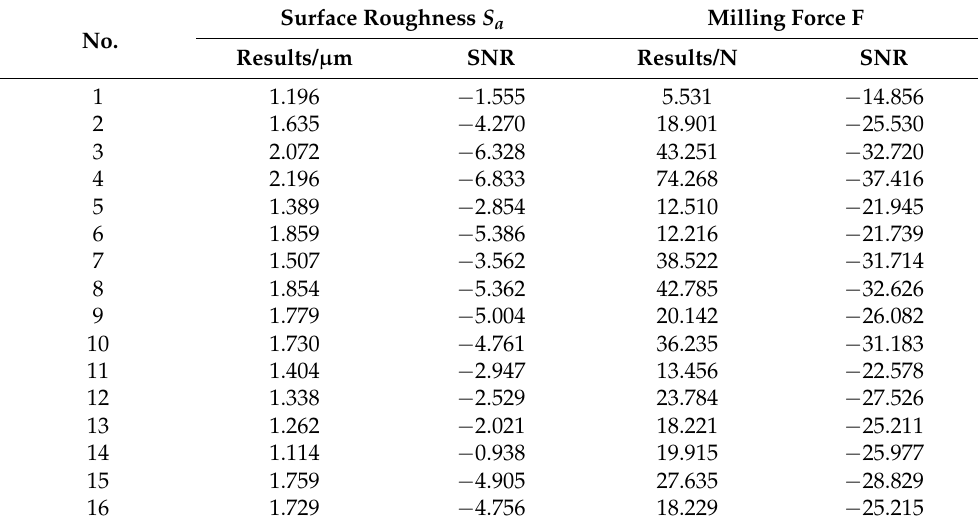
Table 5. Results of orthogonal experiments and SNR of corresponding objectives. Surface Roughness S a Milling Force F No. Results/ µ m SNR